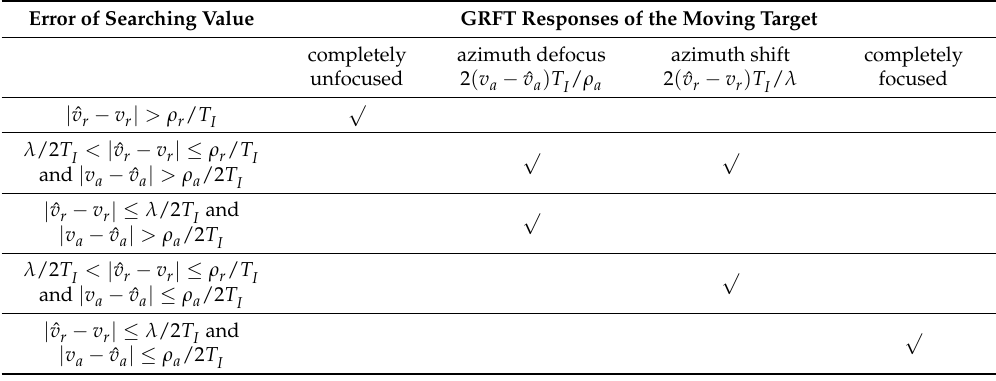
Table 2. GRFT responses to different searching motion